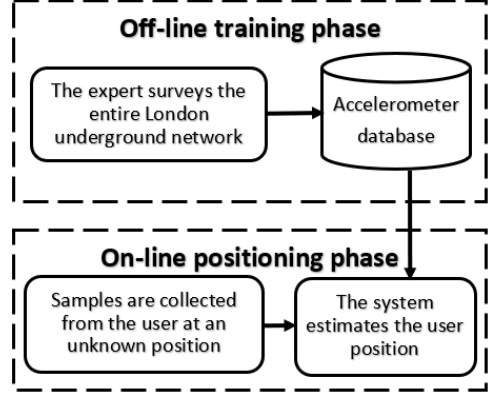
Figure 1. The two phases of our underground tracking